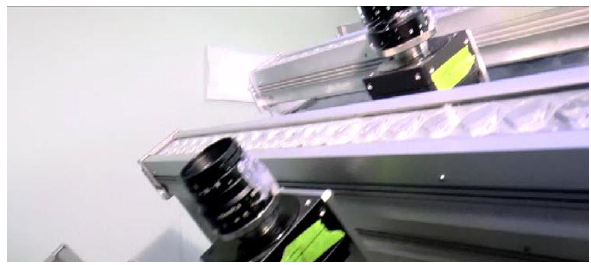
Figure 1b Close-up of cameras and strobe lights Forward-looking cameras are employed for capturing the longitudinal direction ahead of the tunnel mapping system.The forward looking cameras are calibrated to account for geometric distortions, radiometric irregularities and to define relative orientation parameters in the case of camera pairs (see Table 1).